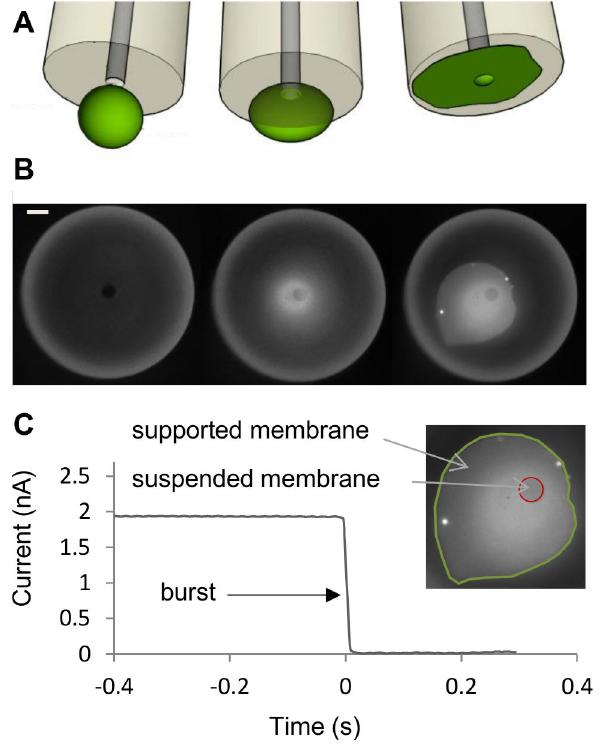
Figure 3. GUV bursting on capillary pipette tip. A and B\ Fluorescence images depicting the steps for GUV patch formation. The glass capillary tip is constantly maintained in focus. The DPhPC GUV is fluorescently labeled with FhuA- Alexa568 molecules. From left to right: the GUV is raised progressively until its top reaches the pipette tip (middle). The GUV bursts on the capillary glass section (right). Scale bar = 20 μm. C\ It leads to an immediate current drop that is monitored by maintaining a constant voltage through the pipette (-20 mV). A seal is obtained if the membrane completely covers the internal pipette diameter, delimited by a red circle in the inset. This suspended membrane is connected to a supported membrane, which is delimited by a green line in the